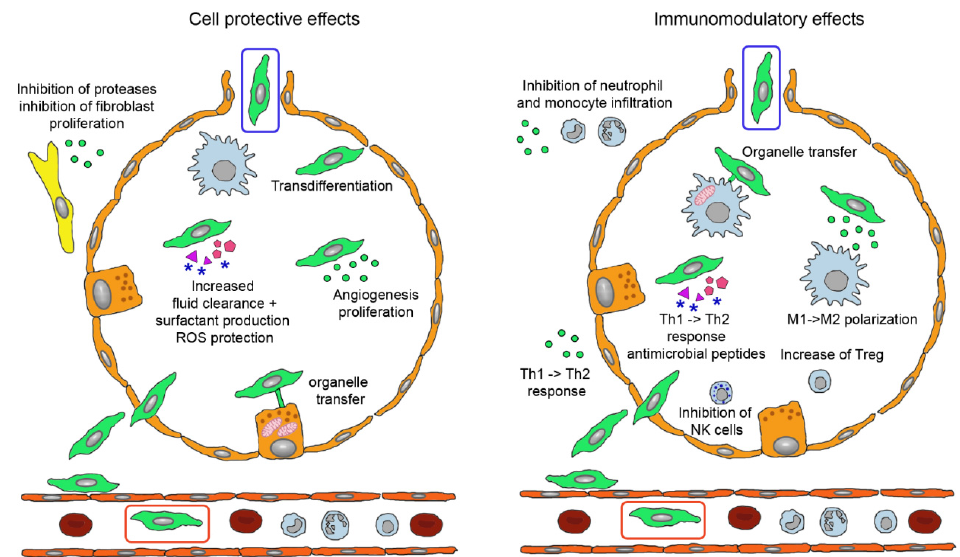
Figure 3. Biological effects of mesenchymal stem cells (MSCs) administered by intravenous (green cell in red box) and inhalation route (green cell in blue box). Injected MSCs have to extravasate and either locate in perivascular position or permeate the epithelial layer to reach the alveolar lumen. They perform tissue-protective and anti-fibrotic effects ( left ) by integration into the epithelial layer, release of extracellular vesicles (EVs) containing Ang-1, KGF, HGF, VEGF, EGF, mRNAs, miRs, membrane components and DNA for anti-apoptotic effects, increase of lung fluid clearance, epithelial cell proliferation and angiogenesis, transfer of mitochondria to alveolar epithelial cells via nanotubules and secretion of cyto- kines and other proteins. EVs containing inhibitors for metalloproteinases and for fibroblast proliferation act in the peri- alveolar space. Immunomodulatory functions ( right ) comprise organelle transfer to alveolar macrophages via nano- tubules, release of TGF- β , PGE2, IDO, IL-10 to decrease T cell activation, TGF- β and HLA-G5 to stimulate Treg, PGE2 and TSG-6 to inhibit M1 activation and secretion of antimicrobial proteins LL-37 and lipocalin-1. The involved mediators either are contained in EVs or present as soluble factors. Abbreviations: Ang-1, angiopoietin-1; EGF, epithelial growth factor; HGF, hepatocyte growth factor; HLA-G5, human leukocyte antigen G5; IDO, indoleamine 2,3-dioxygenase; IL-10, inter- leukin 10; KGF, keratinocyte growth factor; LL-37, cathelicidin; miR, micro RNA; PGE2, prostaglandin E2; Treg, regulatory T cells; TGF- β , tumor growth factor-beta; TSG-6, TNF-stimulating gene 6; VEGF, vascular endothelial growth factor. The contributions of the specific molecules and mediation by free or membrane-en- closed molecules differ between the studies. The majority of the reported effects, namely restoration of epithelial and endothelial function by increased cellular repair and de- creased rate of apoptosis, higher surfactant production, increased resorption of lung fluid, restoration of tight junctions and reduced fibrin production may be mediated by EVs. EVs are also supposed to be involved in reduction of pro-inflammatory and enhancement of anti-inflammatory cytokine secretion, reduction of neutrophil infiltration and M2 polari- zation of alveolar macrophages [41]. Preclinical data identified cell-to-cell contact via pro- grammed death-1 for MSC-T cell interaction, changes in amino acid and lipid metabolism by indoleamine 2,3-dioxygenase (IDO) expression, prostaglandin E2 (PGE2) production, tumor growth factor-beta (TGF- β) and HGF and increased expression of leukocyte prote- ase inhibitor via EGF and HGF as important mechanisms [42]. Epithelial repair was me- diated mainly by angiopoietin-1 (Ang-1), TNF-stimulating gene 6 (TSG-6) and lipoxin A4 (LXA4) and enhanced alveolar fluid clearance through activation of epithelial sodium channel by KGF [43]. Antimicrobiotic effects of MSCs in bacterial ARDS included in- creased phagocytosis of macrophages through mitochondria transfer, increased release of cathelicidin (LL-37) and of IL-10 and decreased tumor necrosis factor alpha (TNF- α) se- cretion mediated by PGE2 and LX4.